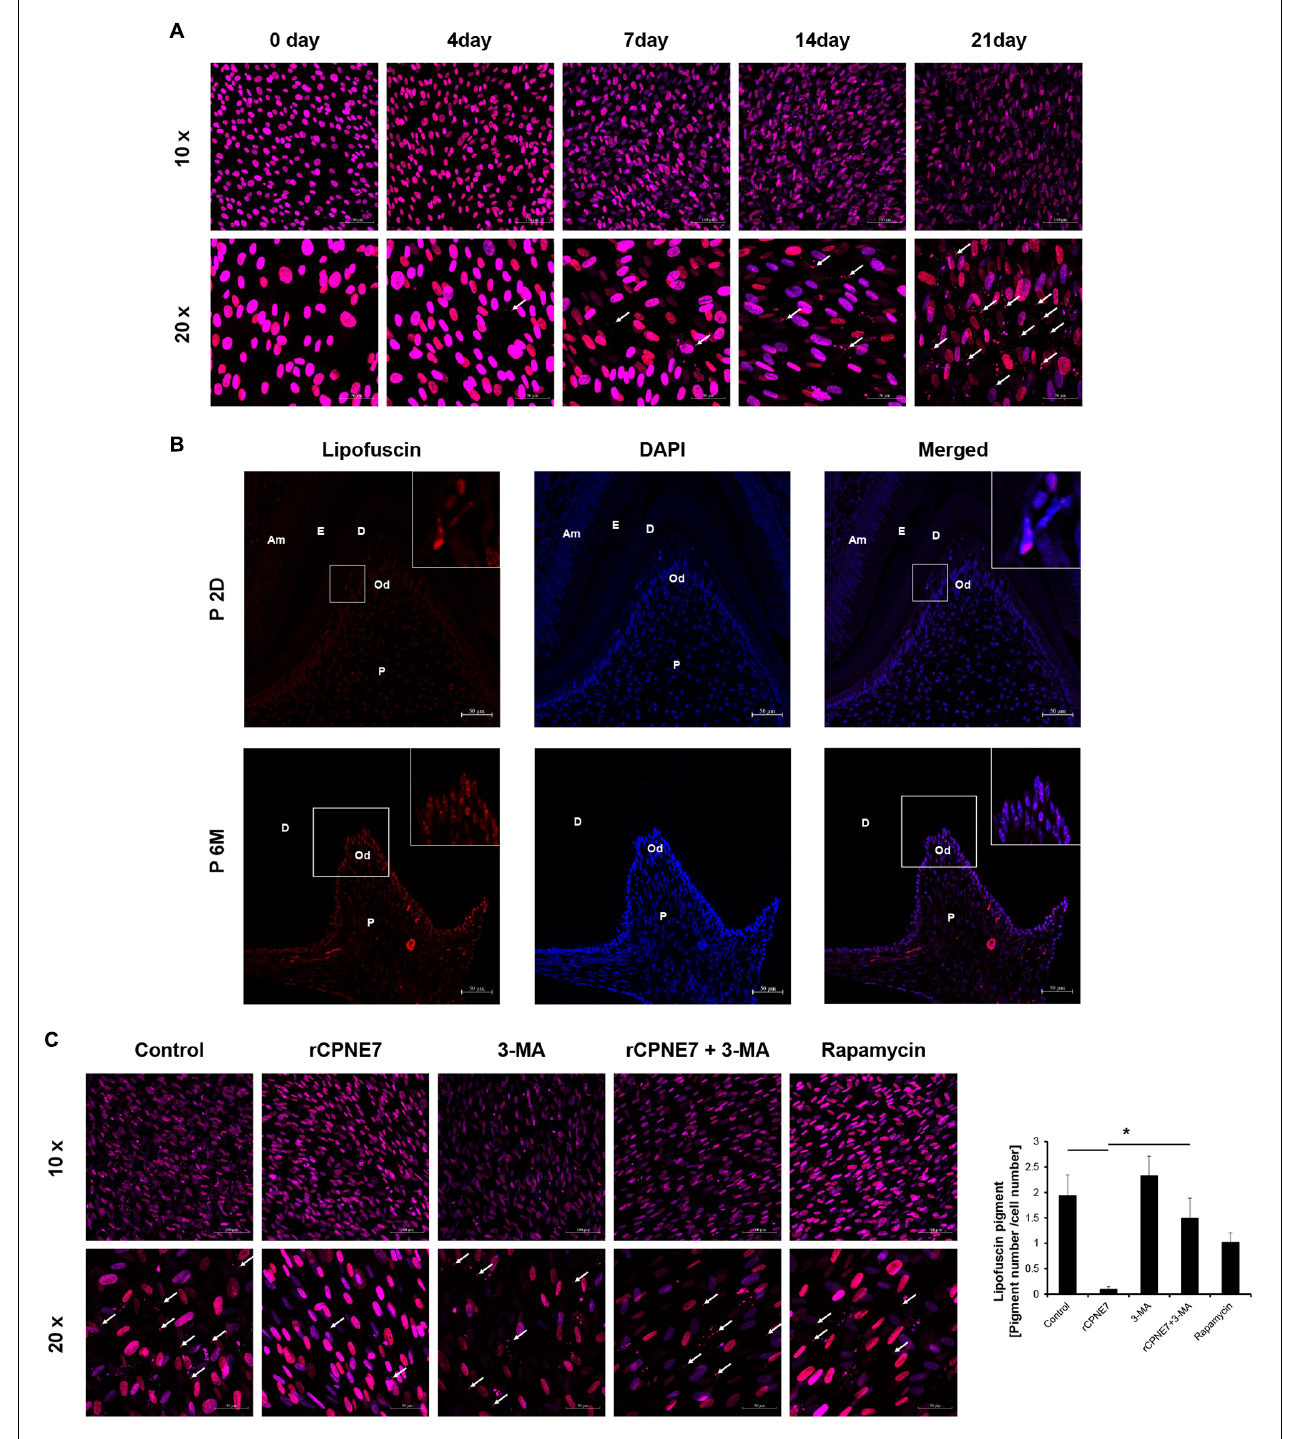
FIGURE 4 | CPNE7 removed lipofuscin in mature odontoblasts. (A) Lipofuscin (red dots; white arrows) accumulation was observed during the differentiation of hDPCs. (B) Lipofuscin pigments were observed in mature odontoblasts on postnatal day 2 (P2D) and at postnatal 6 months (P6M). Scale bars = 50 µ m. Boxed areas are shown at higher magnification. (C) Lipofuscin (white arrows) was analyzed in the control, rCPNE7, rCPNE7 + 3-MA, and rapamycin groups of mature odontoblasts. Scale bars = 10x: 100 µ m and 20x: 50 µ m. Am, ameloblast; E, enamel; P, pulp; Od, odontoblast; D, dentin. Significant differences are shown with asterisks. * P <